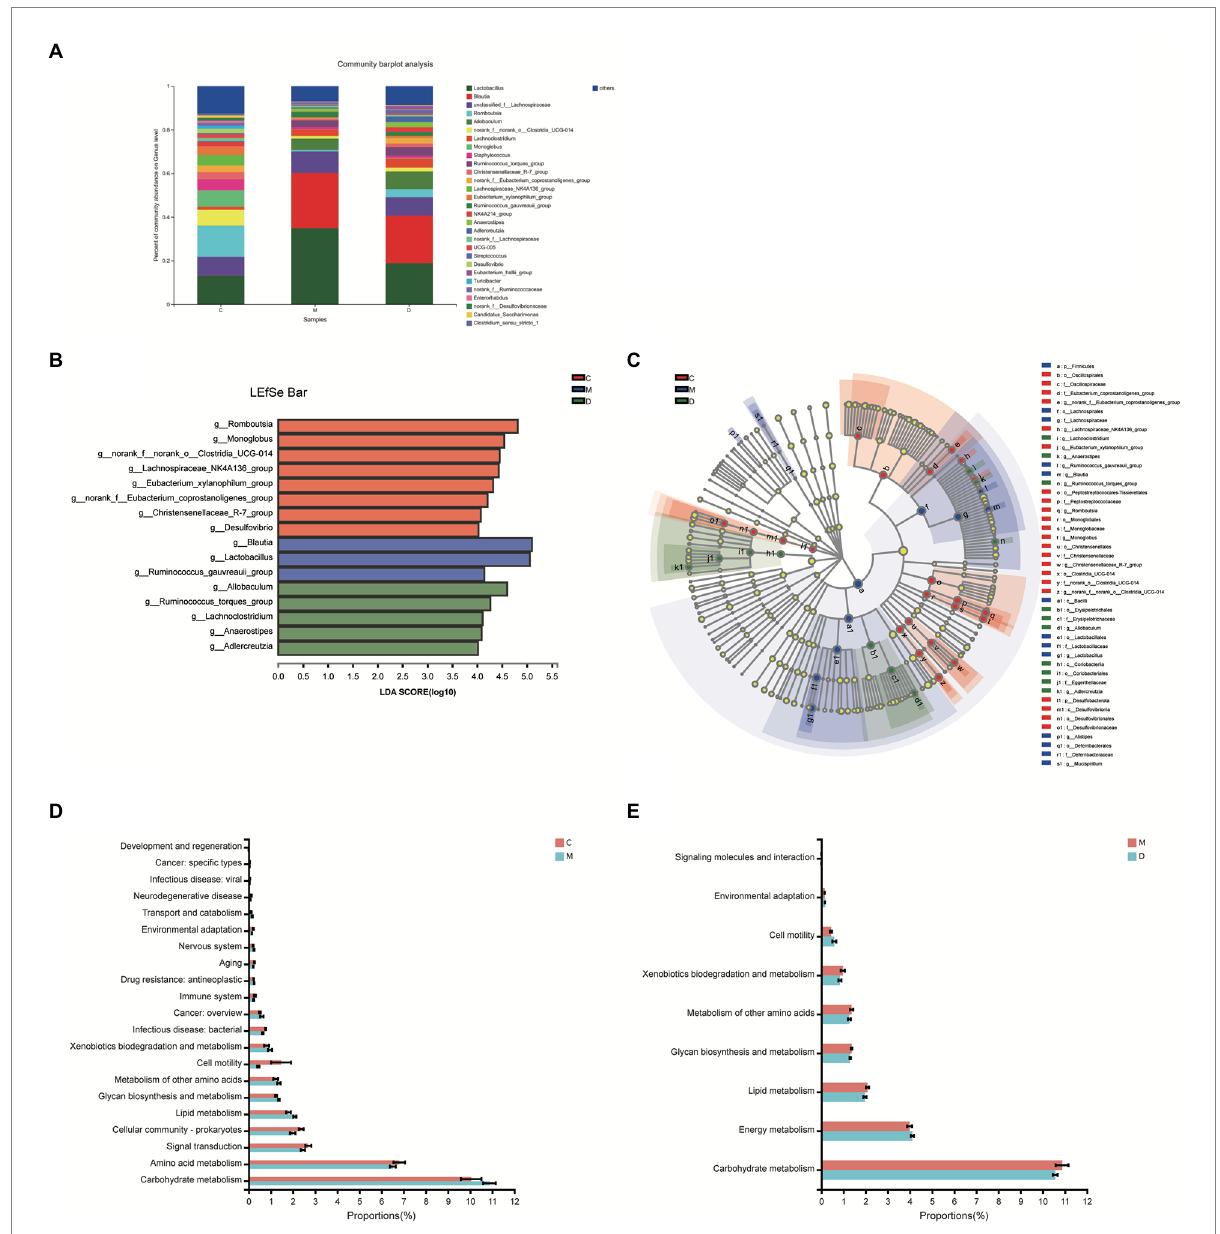
FIGURE 6 Microbiome analysis of the intestinal contents samples. (A) Relative abundance of the gut microbiota at the genus levels. (B,C) Histogram and evolutionary branch diagram of LDA distribution between feces in 3 groups. (D,E) The proportion of gut microbes in different KEGG pathways with significant differences between the two